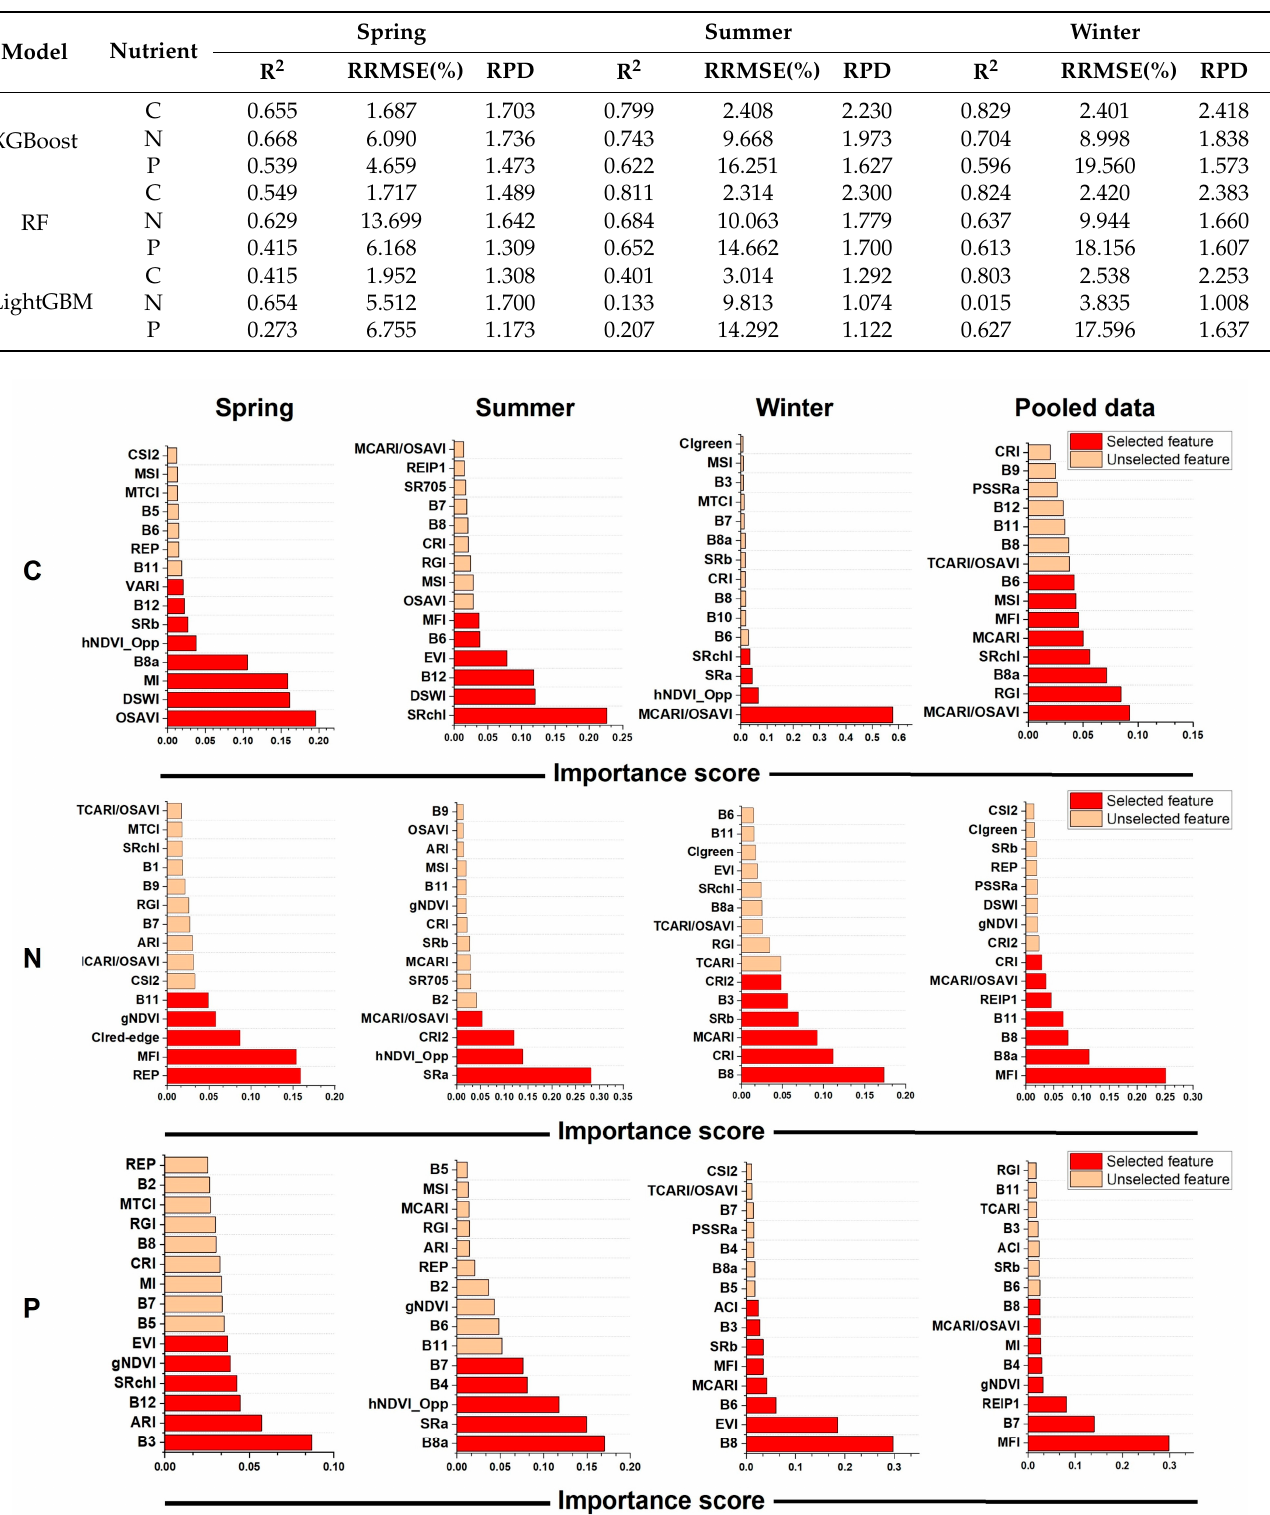
Figure 4. The ranking of the importance scores of the spectral features (bands + VIs) of Sentinel-2 images in correlating with leaf C, N, and P using the dataset of a single season and the pooled dataset of the three seasons. The importance scores were derived from the XGBoost algorithm, and the selected features were marked in